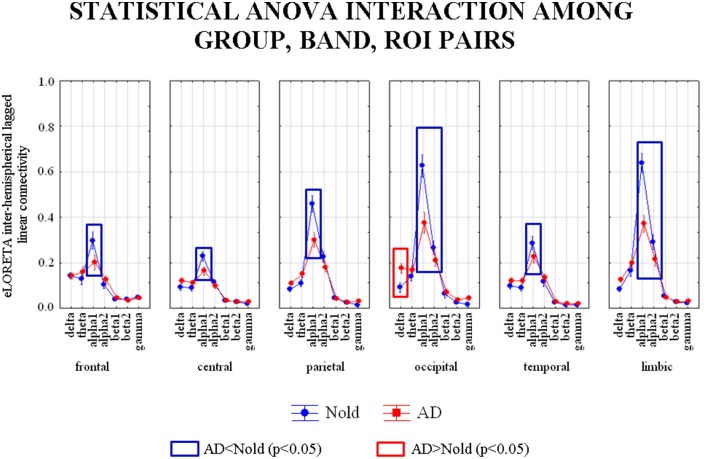
Diagram showing the grand average of the EEG inter-hemispherical lagged linear connectivity computed between left and right hemispheres in the six regions of interest (ROI). These values refer a statistically significant ANOVA interaction [F(30, 6540) = 4.8771, p < 0.0001] among the factors Group (Nold, and MCI), Band (delta, theta, alpha 1, alpha 2, beta 1, beta 2, gamma), and ROI pairs (frontal left-frontal right, central left-central right, parietal left-parietal right, occipital left-occipital right, temporal left-temporal right, and limbic left-limbic right). Subjects' age, education, IAF, and gender were used as covariates. Legend: the rectangles indicate the ROIs and frequency bands in which connectivity values presented the pattern Nold ≠ AD (Duncan test, p < 0.05).